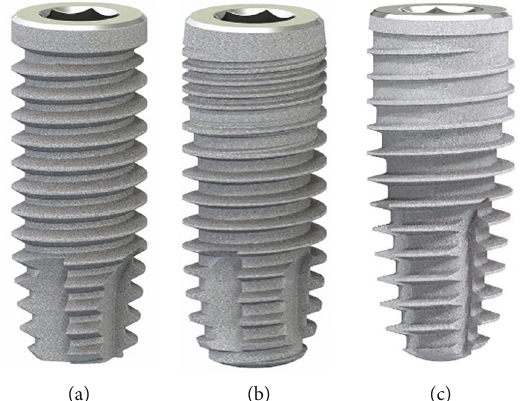
Figure 4: (a) SICace (cylindrical). (b) SICmax (mainly cylindrical). (c) SICtapered (conical).